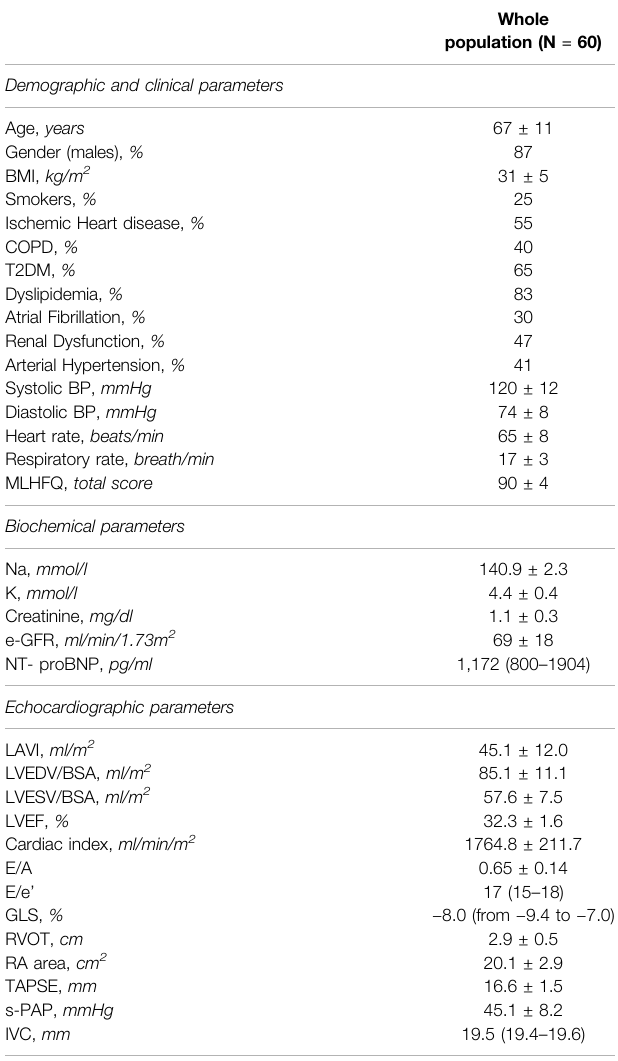
TABLE 1 | Baseline characteristics of patients that completed the study.